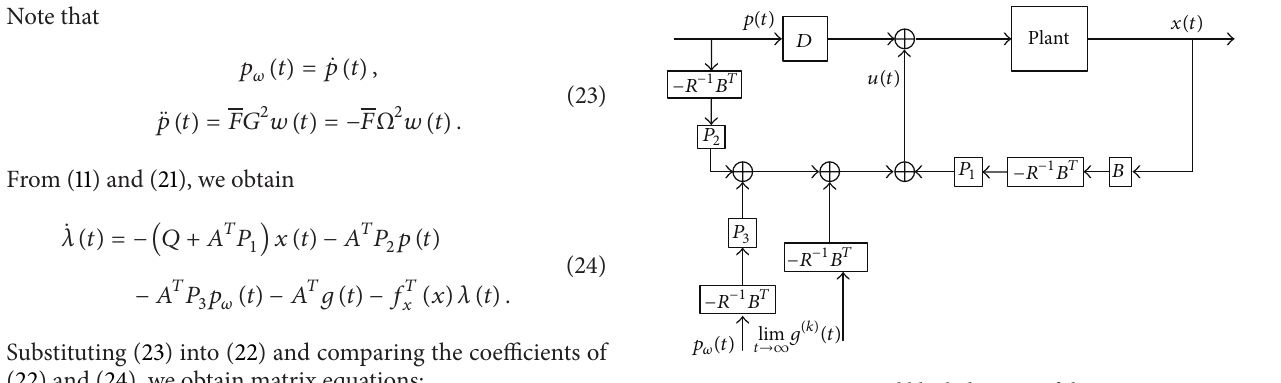
Figure 2: Control block diagram of the